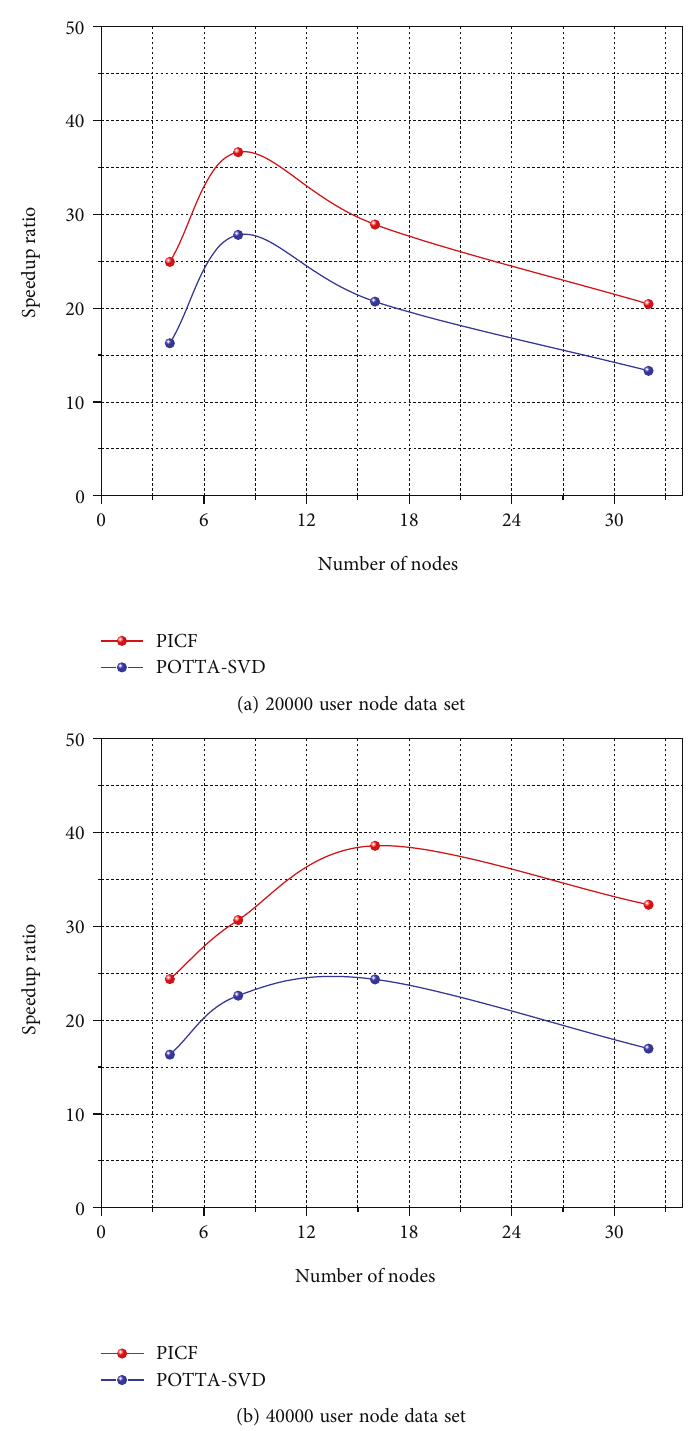
Figure 14: Performance comparison of two Spark parallel algorithms on di ff erent node